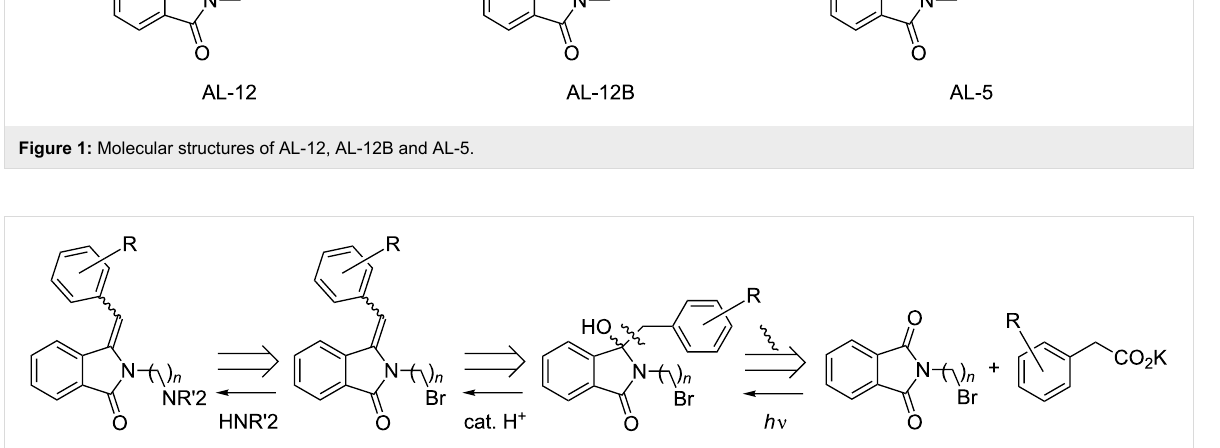
Scheme 1: Retrosynthetic analysis of AL-12, AL-12B and AL-5 (in their neutral forms) and their derivatives.